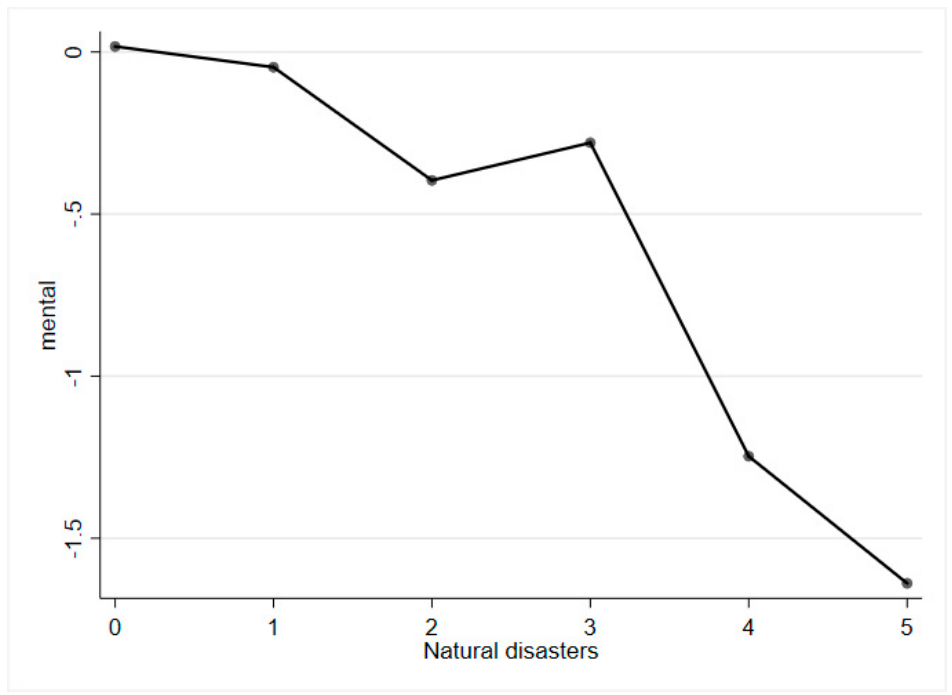
Figure 1. Graph of natural disasters and mental health.